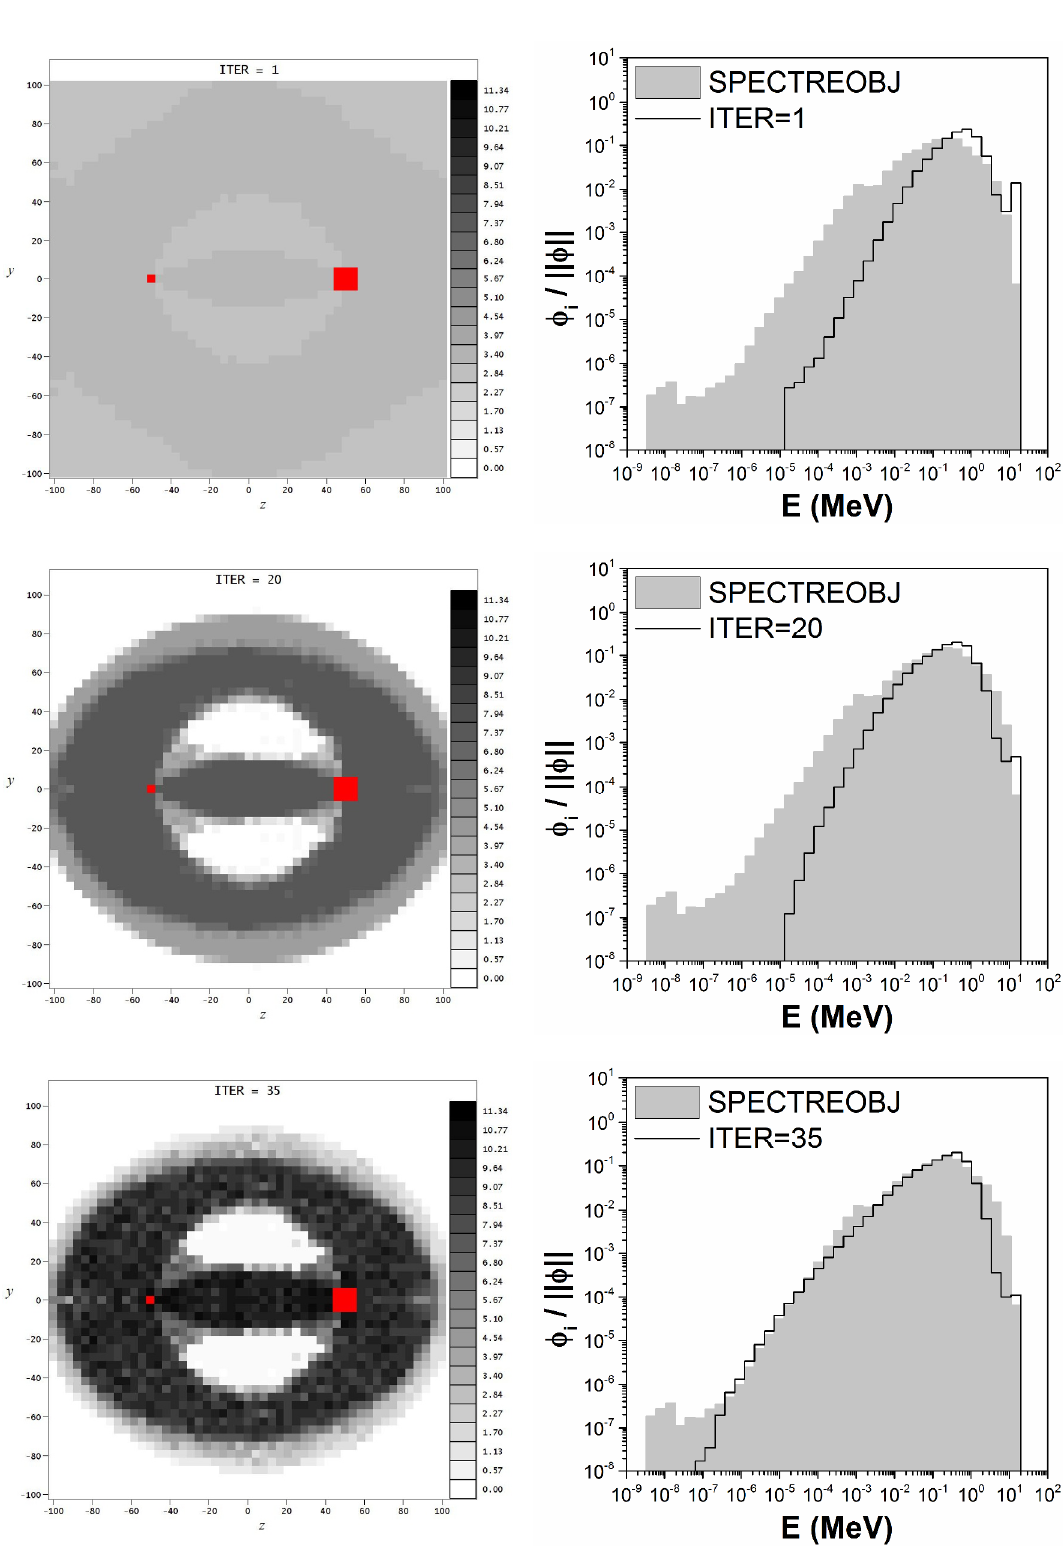
Figure 1. Iterative design of a neutron spectrum shaper with the optimization